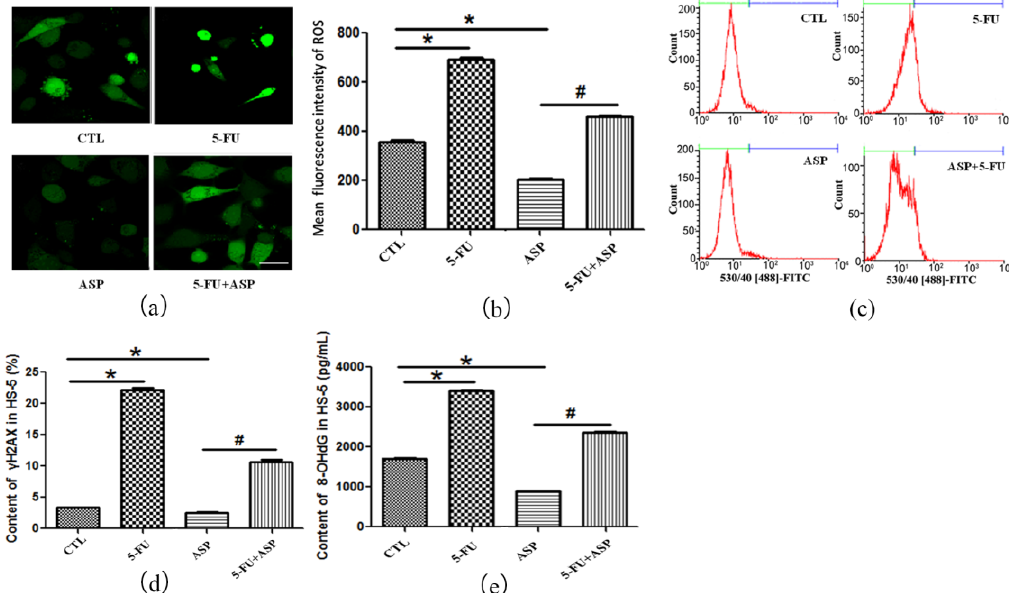
Figure 3. ASP alleviates oxidative stress caused by 5-FU in BMSCs. ( a ) The levels of reactive oxygen species (ROS) in HS-5 cells were measured by dichlorodihydrofluorescein diacetate (DCF-DA) staining and fluorescence microscopy (Scale bar = 50 µ m); ( b ) The mean fluorescence intensity of ROS was quantified and is presented as means ± SD; ( c ) DSB of DNA was determined by γ H2AX flow cytometry. Representative flow cytometric images of γ H2AX in HS-5 cells are presented. The green line represents γ H2AX negative cells and the purple line represents γ H2AX positive cells; ( d ) The results of γ H2AX content in HS-5 cells determined by flow cytometry are presented as means ± SD; ( e ) DNA damage response was detected by 8-OHdG supernatant Enzyme-linked immuno sorbent assay (ELISA). The results of 8-OHdG content in HS-5 cells are presented as means ± SD. * p < 0.01 vs. control group, # p < 0.01 vs. 5-FU group. Table 1. The levels of ROS, T-SOD, and GSH-PX in HS-5 cells ( X ̅ ± S , n = 3).